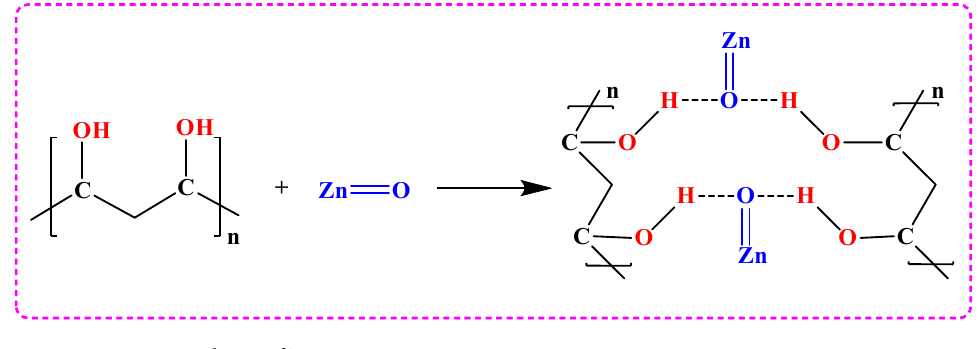
Figure 1. Reaction scheme of ZnO/PVA